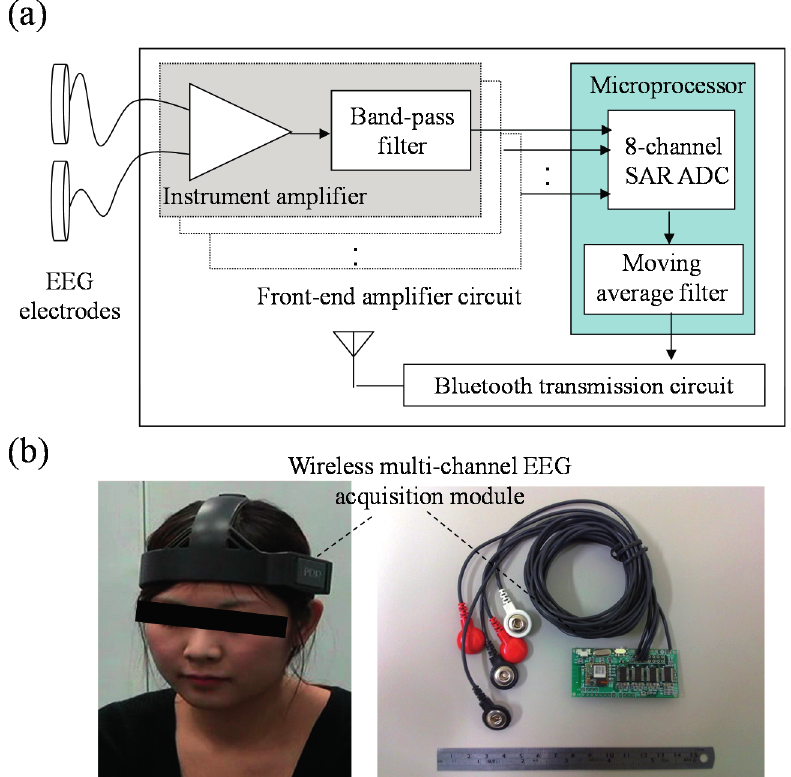
Figure 2. ( a ) Block diagram and ( b ) photograph of wireless multi-channel EEG acquisition